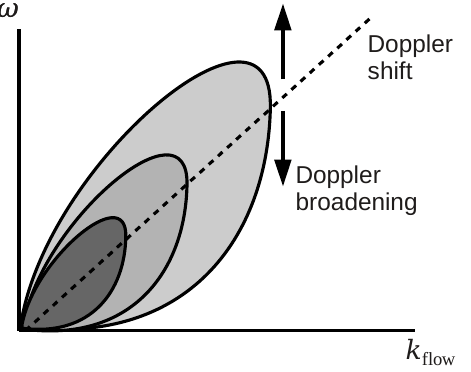
Fig. 1. Sketch of the inertial-range spectrum in the wavenumber- frequency domain. The wavenumber is aligned with the mean flow direction. Fig. 2. Time series plot of the magnetic field magnitude, the ion